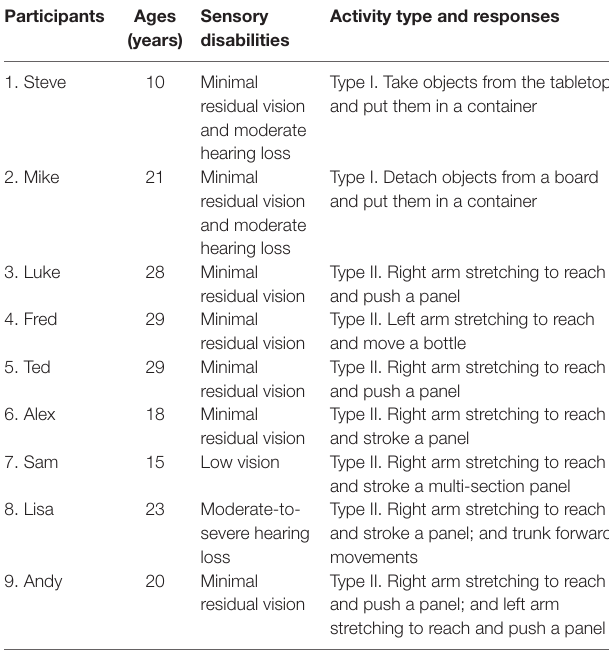
TaBle 1 | Participants’ characteristics, activity, and